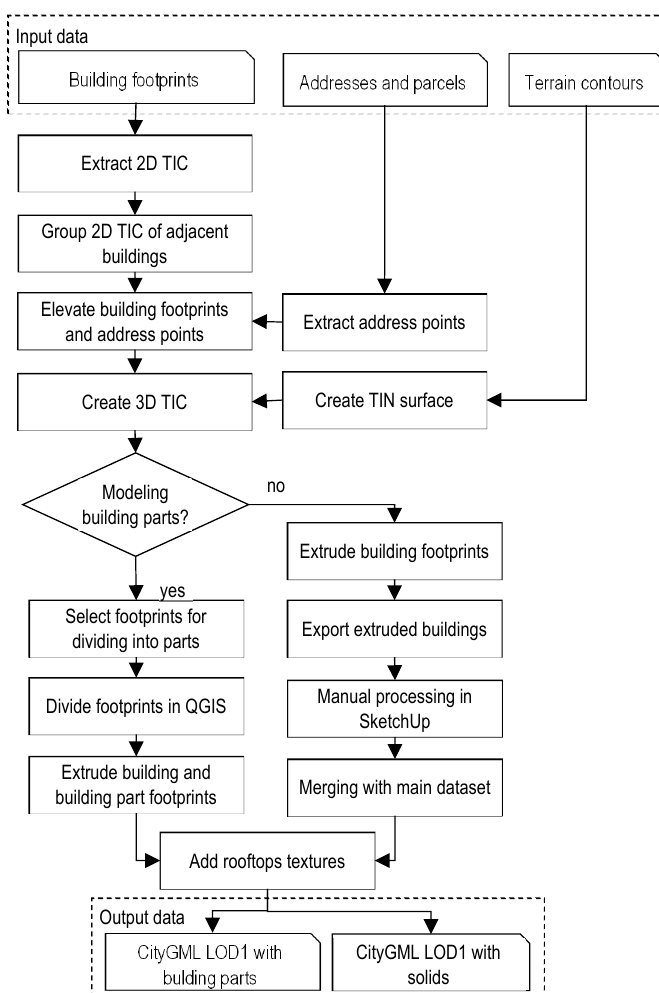
Figure 1. Modeling workflow for the development of the 3D city